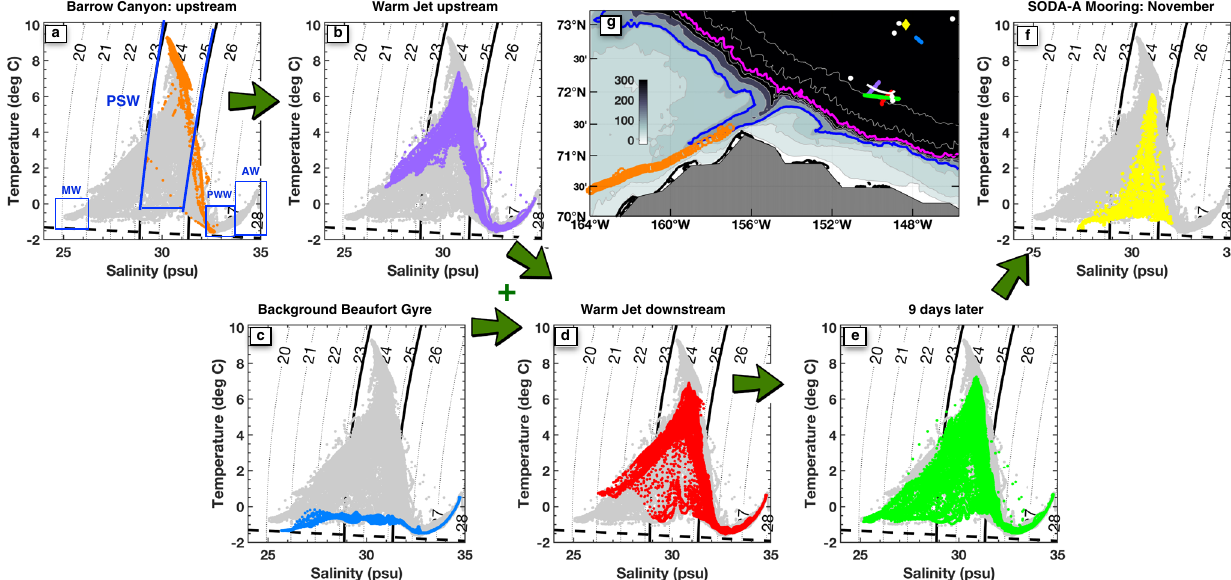
Fig. 3 Context and evolution of Paci fi c Summer Water (PSW). a Temperature and salinity characteristics of water transiting through Barrow Canyon from pro fi ling fl oats and gliders (orange dots, see “ Methods ” ), the location of which are shown in g , and all observations (gray dots, same in all panels). Isopycnals are contoured every 1 kg m − 3 and the 23.2 and 25.2kg m − 3 isopycnals that bound PSW are in bold. Labeled water masses in a include Paci fi c Summer Water (PSW), cool fresh Melt Water (MW), Paci fi c Winter Water (PWW), and Atlantic Water (AW), expanded discussion in Supplementary. The freezing point of seawater is indicated with a dashed black line. b Fast CTD data from the cross-jet survey section shown in Fig. 2. c Fast CTD data of typical background Beaufort Gyre water measured on 18 Sept. d Fast CTD data from a slightly downstream section through the meandering warm jet, re fl ecting stirring and mixing between b and c . e Fast CTD data from a subsequent survey through the same region 9 days later on 24 Sept (Fig. 5). f Data from the SODA-A mooring measured from 25 Oct – 15 November 2018. g Map showing locations of all measurements, colors match those in each panel; the 100 m (blue) and 1000 m (magenta) isobaths are contoured, as in Fig. 1. The white line and dots indicate the locations of the Wirewalker drift and CTD stations respectively, data for which is shown in Fig.